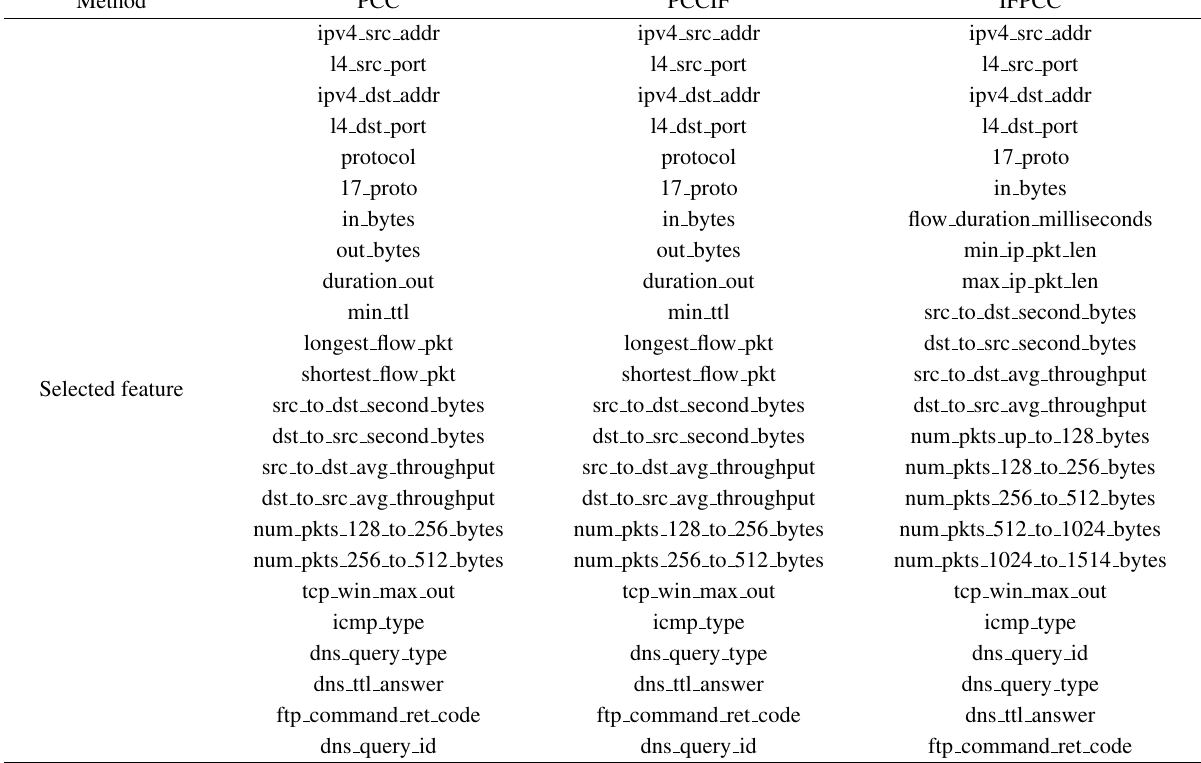
Table 5 List of selected features from NF-UNSW-NB15-v2.